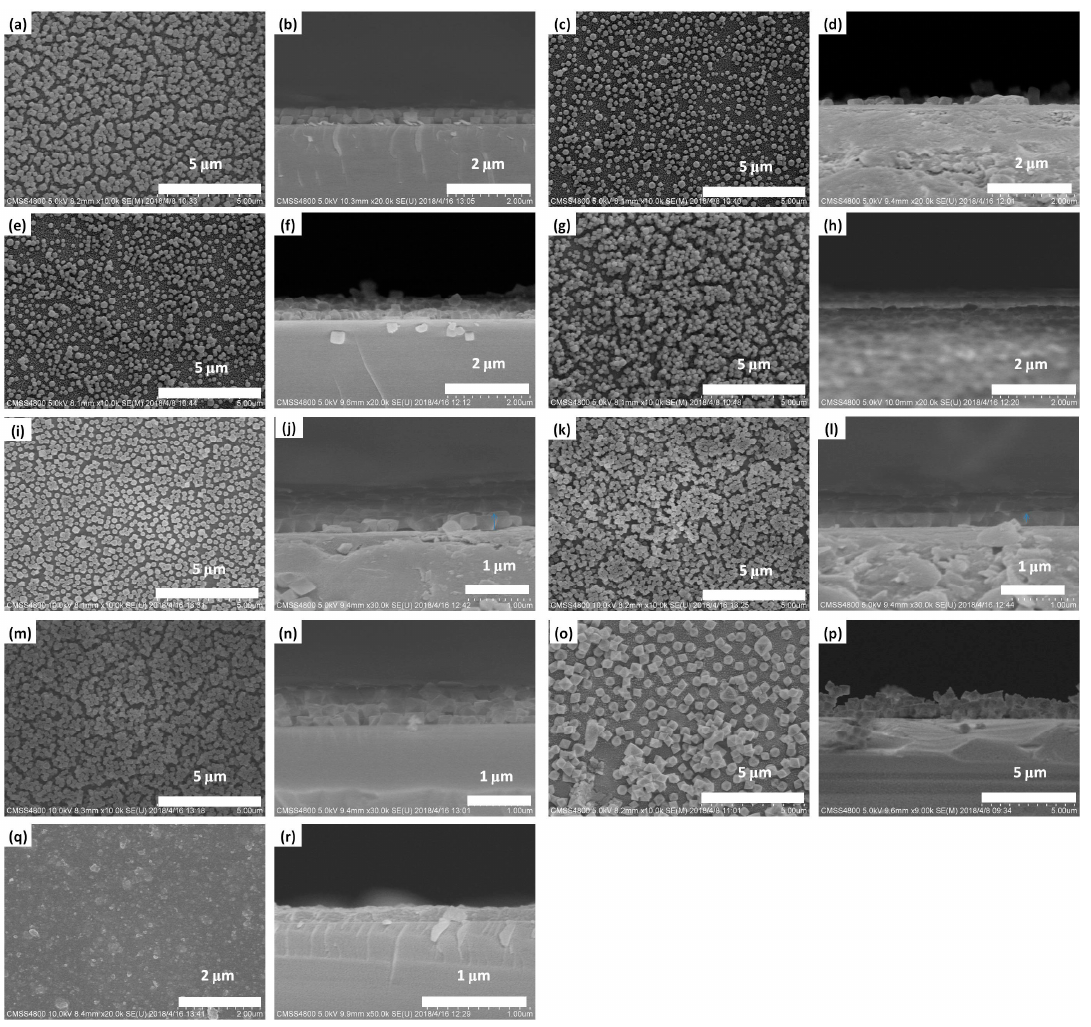
Figure 2. Top-view ( a , c , e , g , i , k , m , o , q ) and side-view ( b , d , f , h , j , l , n , p , r ) SEM images of MOF optical thin films. ( a , b ) OTF-SP, ( c , d ) OTF-DP-1, ( e , f ) OTF-DP-3, ( g , h ) OTF-DP-5, ( i , j ) OTF-SA-1, ( k , l ) OTF-SA-2, ( m , n ) OTF-SA-3, ( o , p ) OTF-DG, ( q , r ) OTF-LBL.